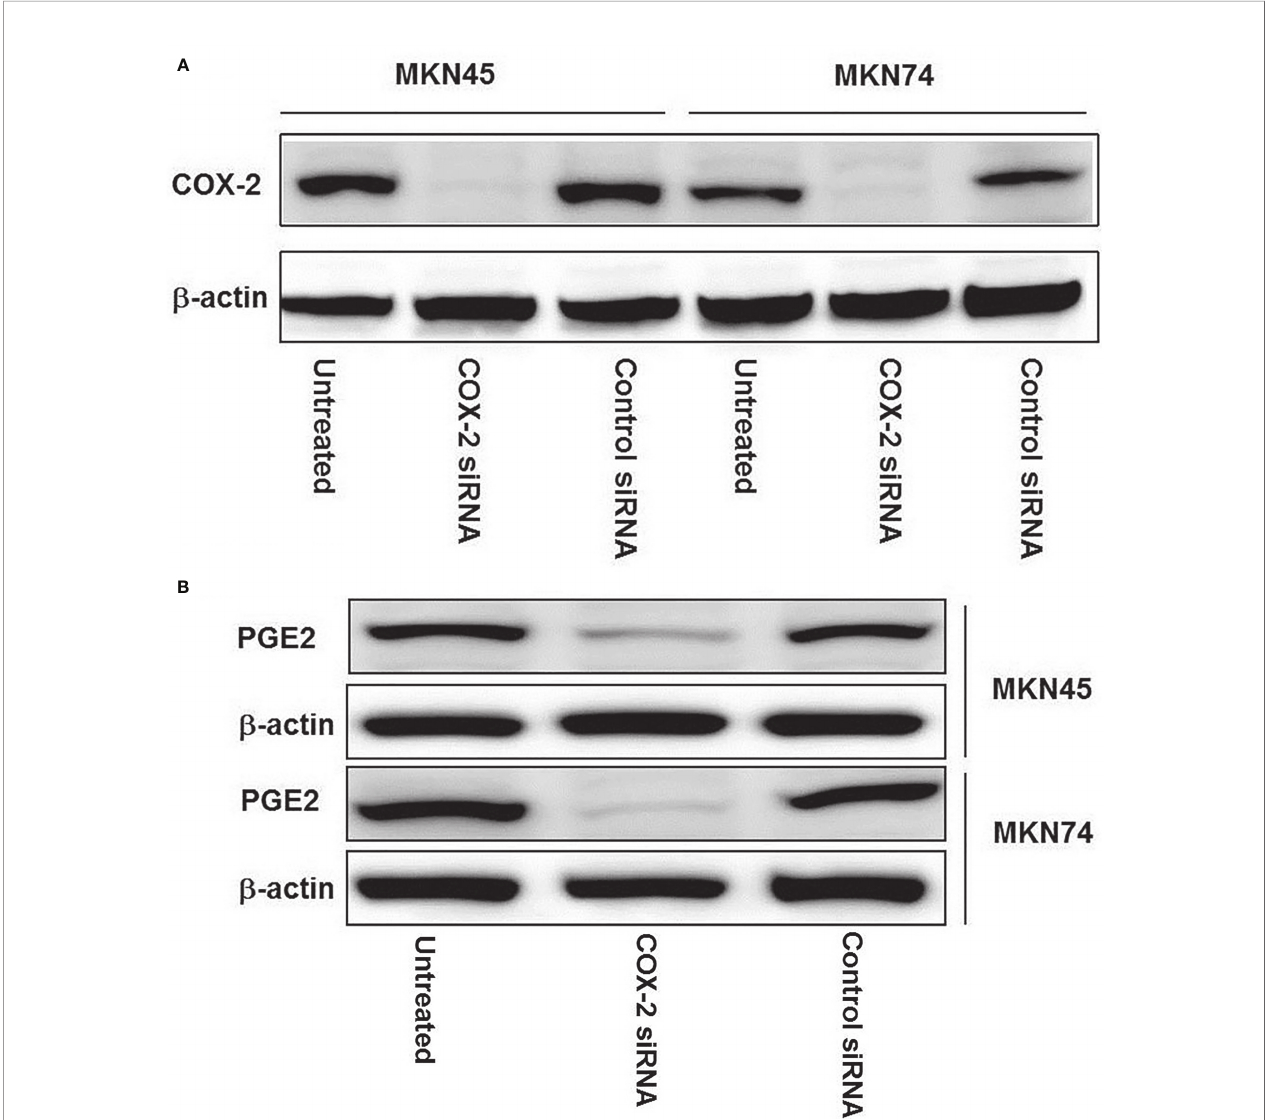
FIGURE 3 | The expression of COX-2 protein in gastric cancer cell line after silencing of CXCL12 gene. Knockdown of COX-2 by COX-2 siRNA was con fi rmed by immunoblotting in expressed COX-2 gastric cancer cell lines: MKN74 and MKN45. COX-2 siRNA duplex oligoribonucleotides were transfected into cells for 48 h; the proteins were extracted and then subjected to Western blotting (A) . After being transfected with COX-2 siRNA in MKN45 and MKN74 cells, a signi fi cant inhibited expression of PGE2 was observed (B) . The experiments were performed in